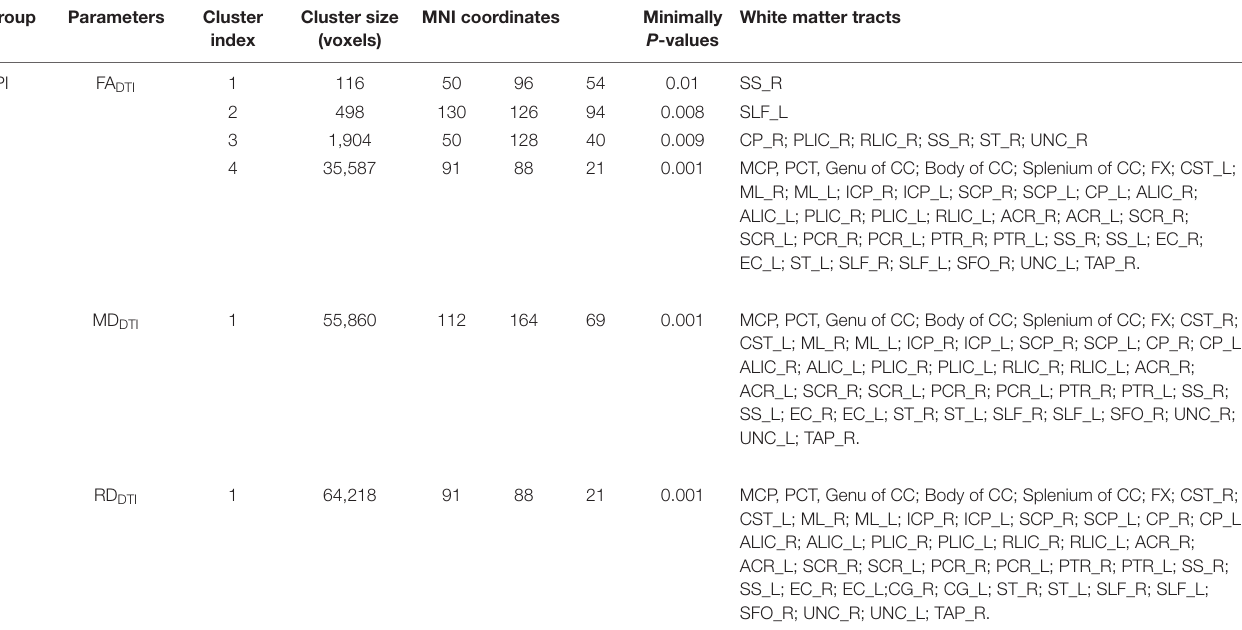
TABLE 2 | Abnormal white matter fibers derived DTI different parameters in LPI group compared with NC group.